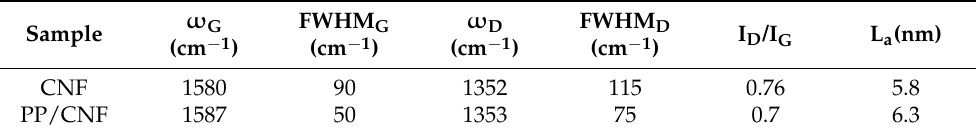
Figure 3. ( a ) Raman spectra of PP, as-received CNFs and PP/5wt.% CNF composite. (The dotted lines are to guide the eye), ( b ) Raman fit in the G and D wavenumber range of PP/5wt.% CNF composite (blue line), showing the different components: CNFs (violet line) and PP (black line). Table 1. D and G, FWHM, I D /I G , and La calculated according to [32], of as-received CNFs and PP/5wt.% CNF composite.